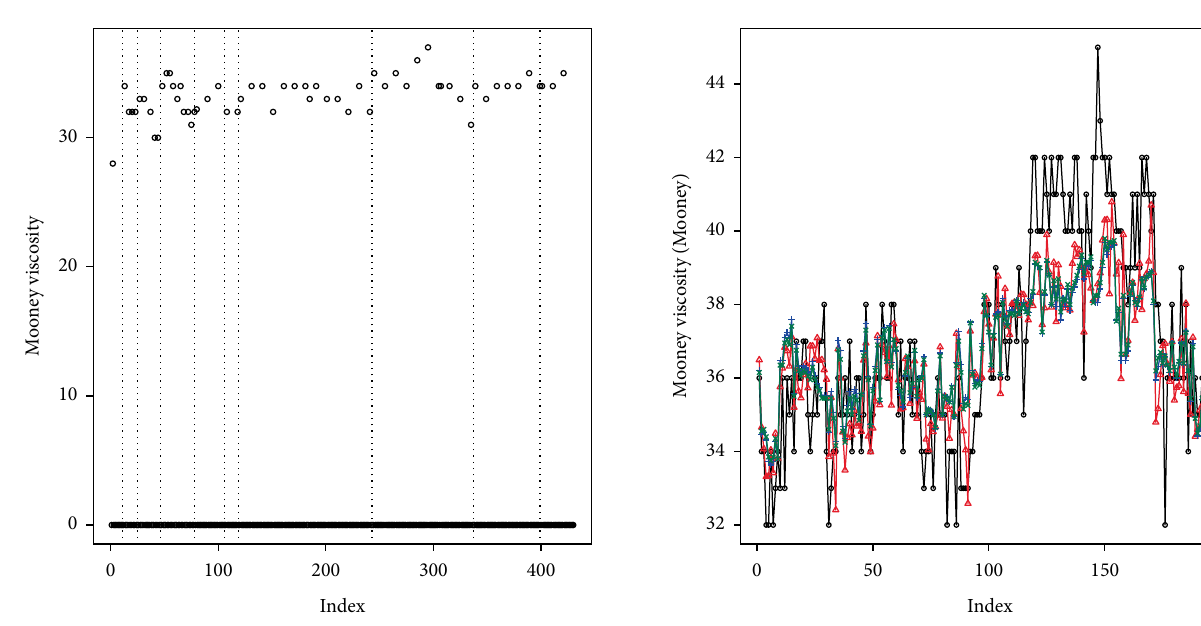
Figure 3: Mooney viscosity values of first 10 batches.